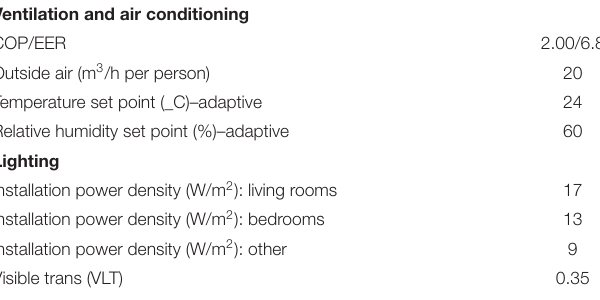
TABLE 4 | Building HVAC system and lighting